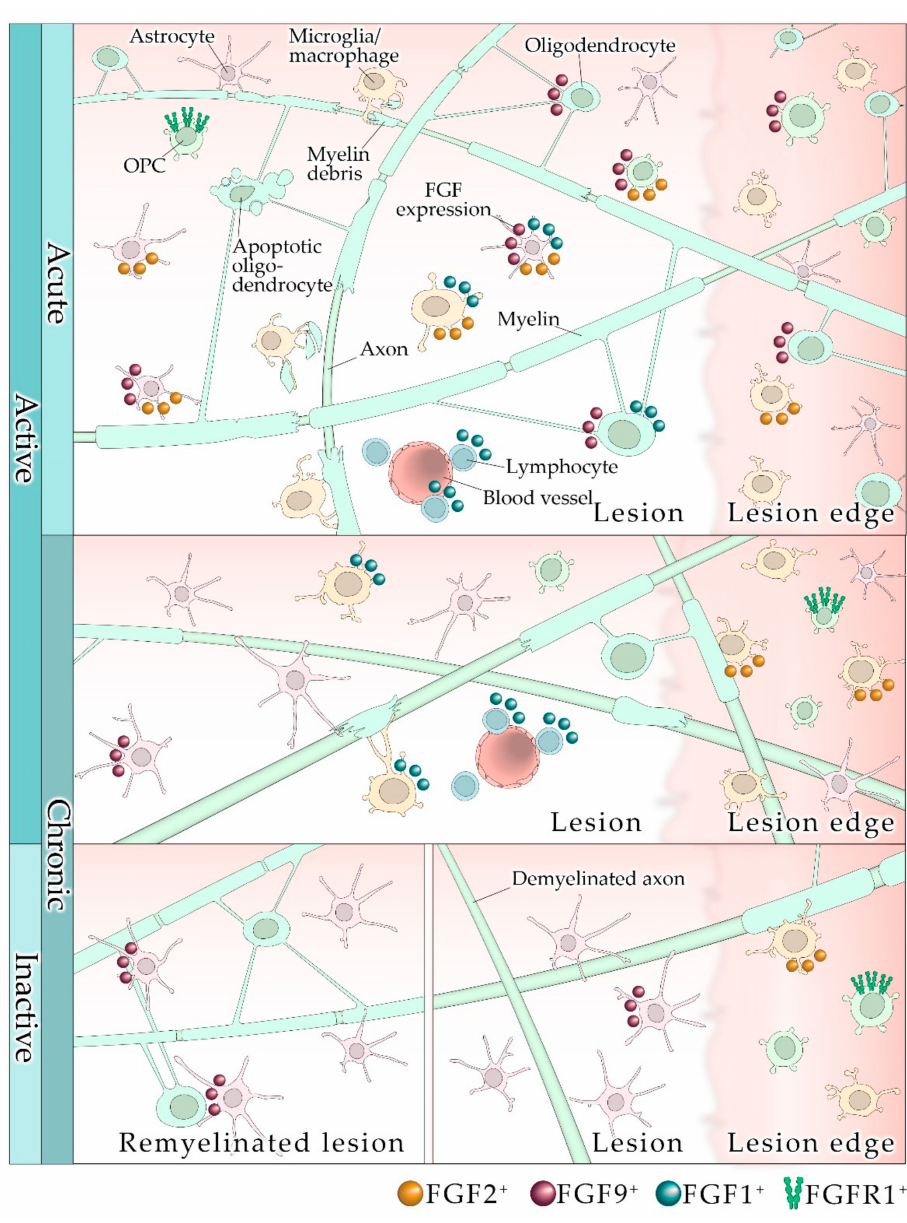
Figure 1. Lesion types and FGF/FGFR expression in multiple sclerosis. Depending on the lesion type, FGFs are associated with myelin damage and inflammation to a varying degree. Abundancy is especially high in acutely demyelinating